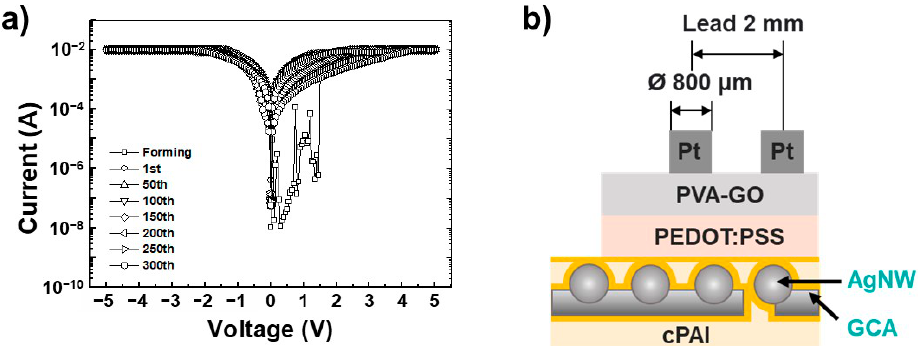
Figure 9. ( a ) Memory characteristics of the Pt/PVA-GO/PEDOT:PSS/GCA/AgNW(9)/GCA/cPAI structure ReRAM, ( b ) cross-sectional structure of ReRAM.